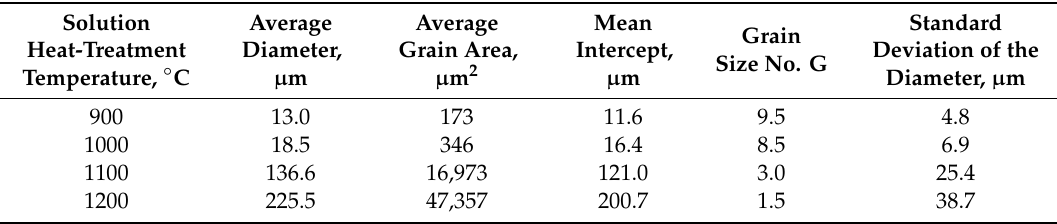
Table 2. E ff ect of the solution heat-treated temperature on grain Table 2. Effect of the solution heat-treated temperature on grain size.